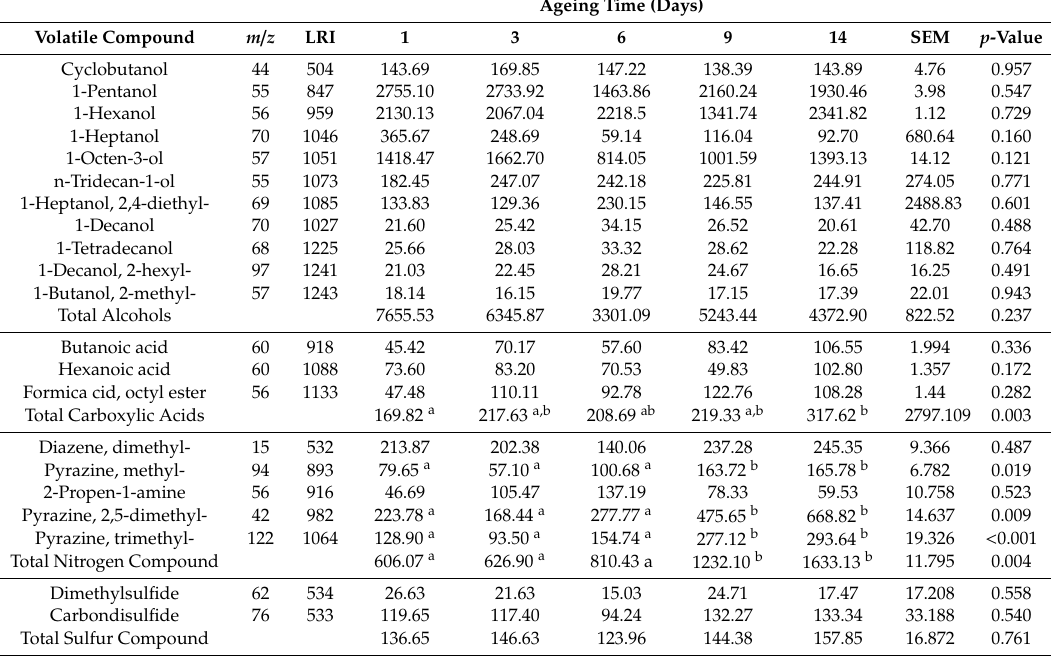
Table 4. E ff ect of aging time in the alcohols, carboxylic acids, nitrogen compounds, and sulphur compounds content, expressed as quantifier area units (AU × 10 3 / g), of donkey meat steaks aged for